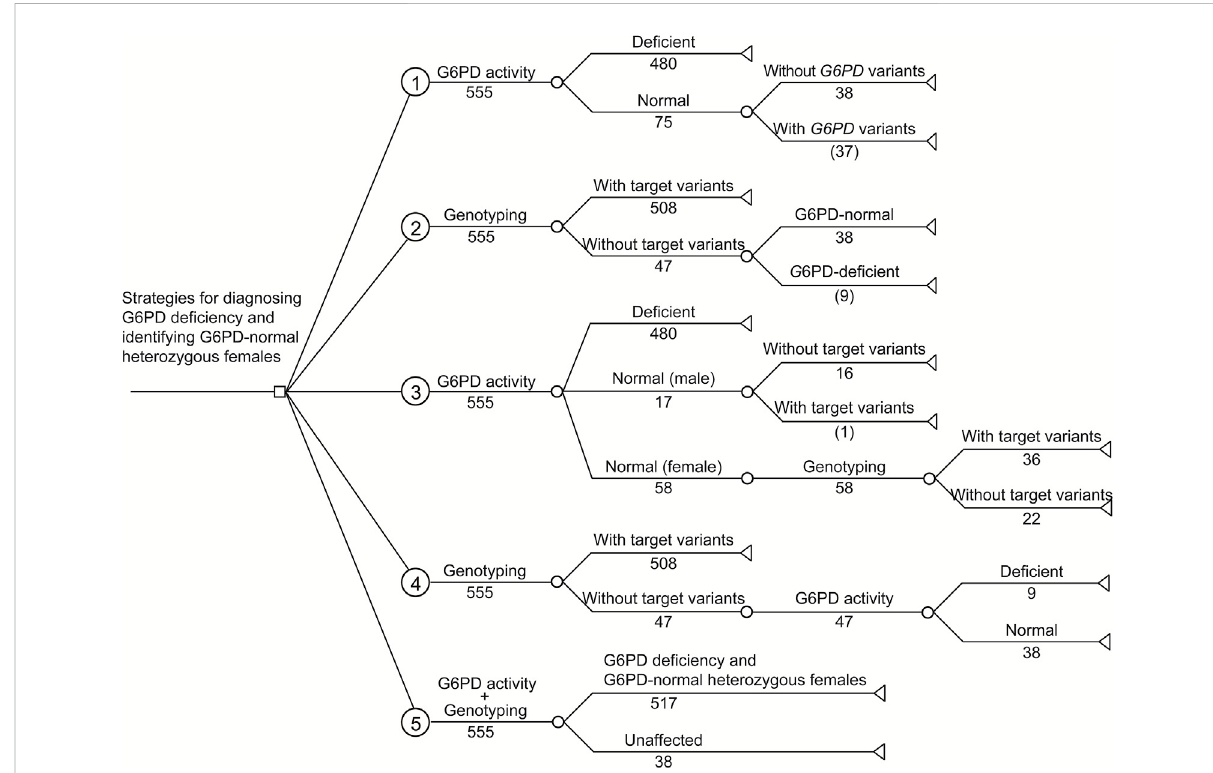
FIGURE 2 Decision-analytic model of fi ve strategies for diagnosing G6PD de fi ciency and identifying G6PD-normal heterozygous females from infants with positive newborn screening results. Based on the experimental results, the numbers of cases are listed. Number in parenthesis indicates the number of infants with missing diagnosis or identi fi cation.